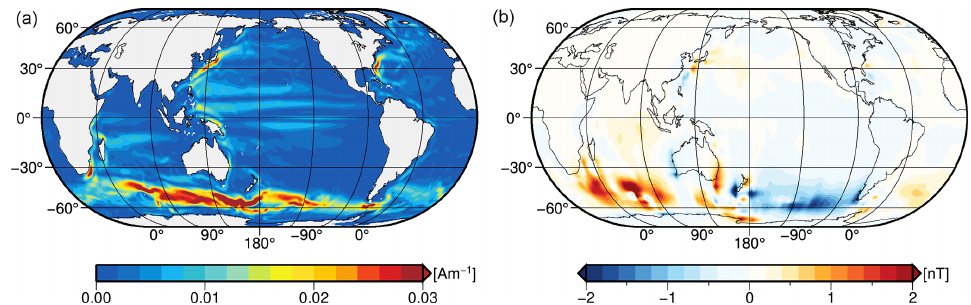
Figure 1. (a) Annual mean oceanic electric current density j of the year 2014. (b) Corresponding radial part of the annual mean ocean- induced magnetic field at sea